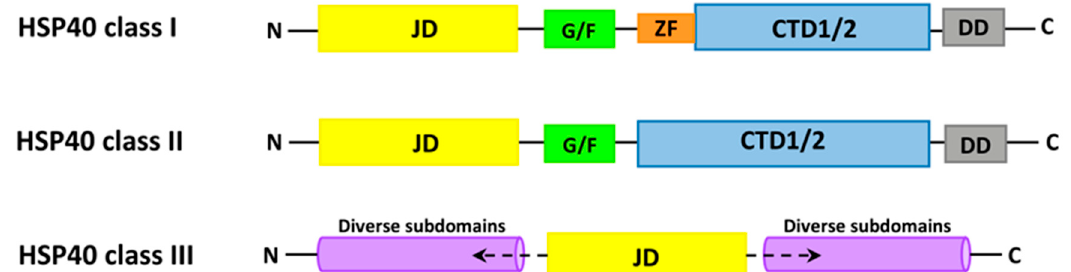
Figure 6. Domain structure of the three HSP40 (DnaJ). Subfamilies: class I, class II and class III. The different domains are marked in the following way: JD, J domain; G/F, Gly-Phe rich region; ZF, Zinc finger (Zn 2+ -binding domain); CTD, C-terminal domain and DD, dimerization domain.